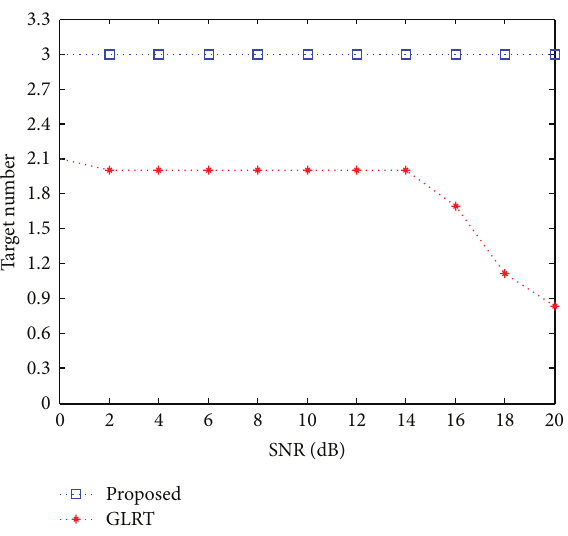
Figure 6: The number of estimated SOIs in case B.